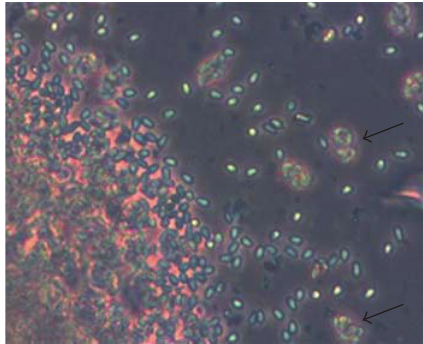
Figure 2: Phase contrast view (400x) of meiospores of Kneallhazia solenopsae in workers of Solenopsis richteri . Because of the grinding process, the octect membrane usually brakes and most spores are released in the aqueous extract. A few intact octects (arrows) are shown with meiospores inside.